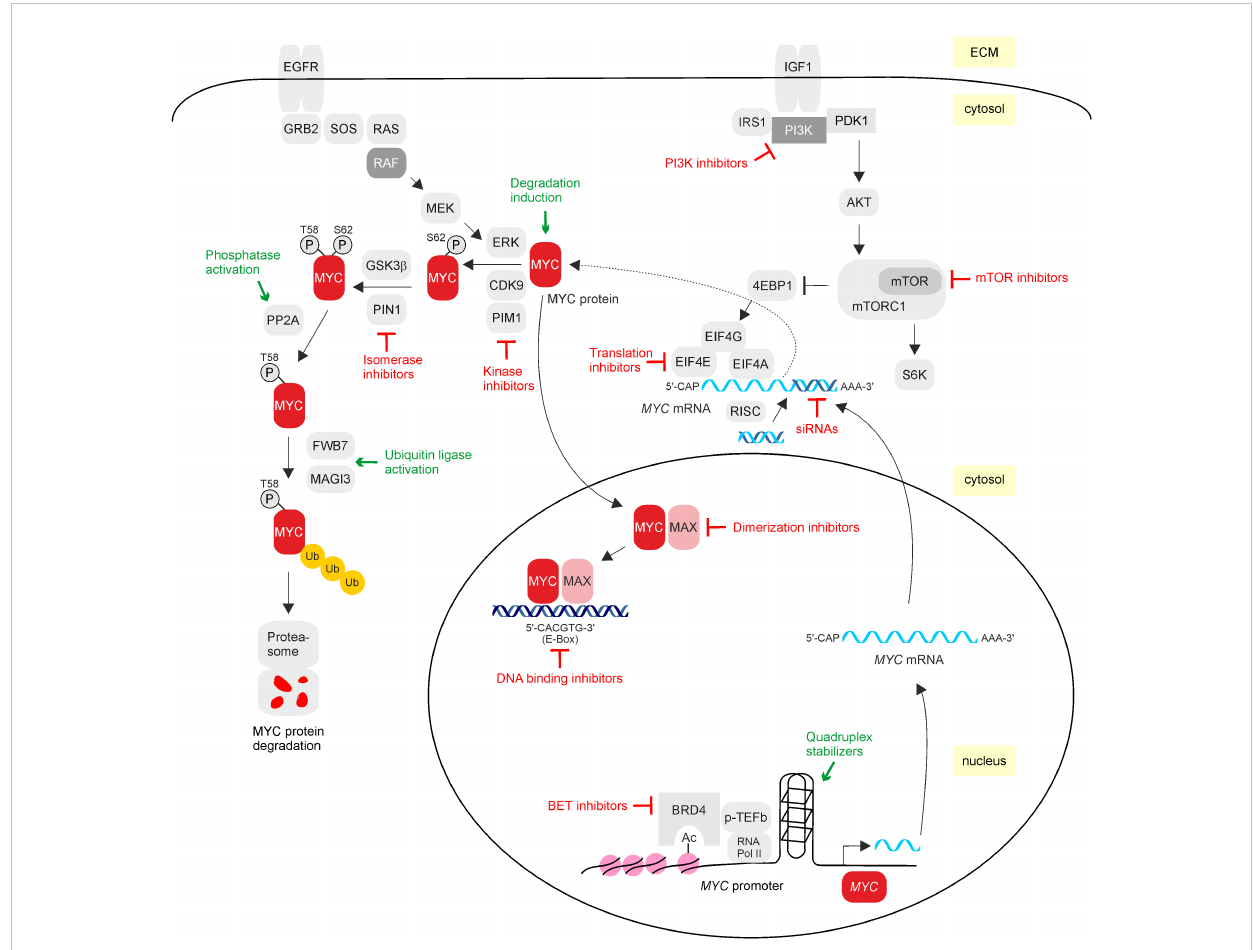
FIGURE 3 MYC inhibitors. Overview of direct and indirect possibilities to interfere with the activity of oncogenic MYC. MYC can be inhibited on the transcriptional level by preventing MYC mRNA expression, post-transcriptionally by preventing mRNA translation, post-translationally by interfering with upstream signaling or by inducing premature protein degradation, and fi nally by blocking dimerization with MAX and/or DNA binding, thereby impairing oncogenic target gene expression. Inhibitory effects on MYC are depicted in red, and events that activate MYC-inhibitory pathways are in green. Relevant molecules interfering with oncogenic MYC activity are listed in Table